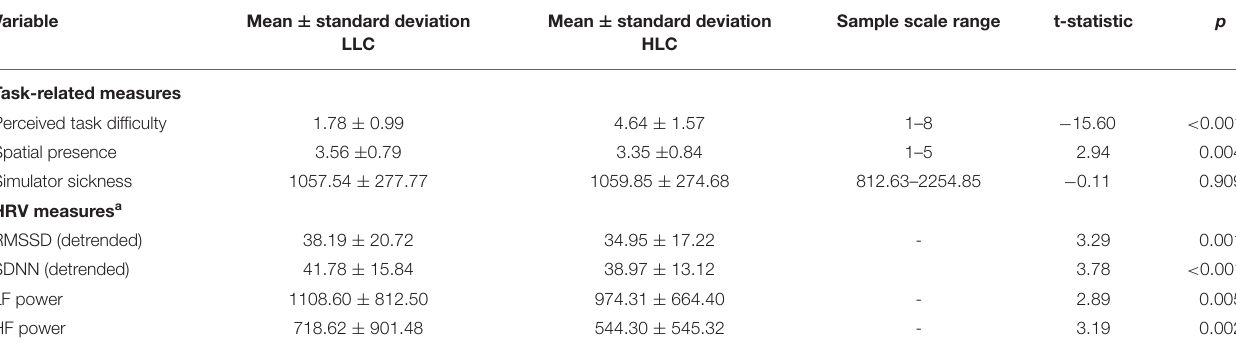
TABLE 2 | Task-related and HRV